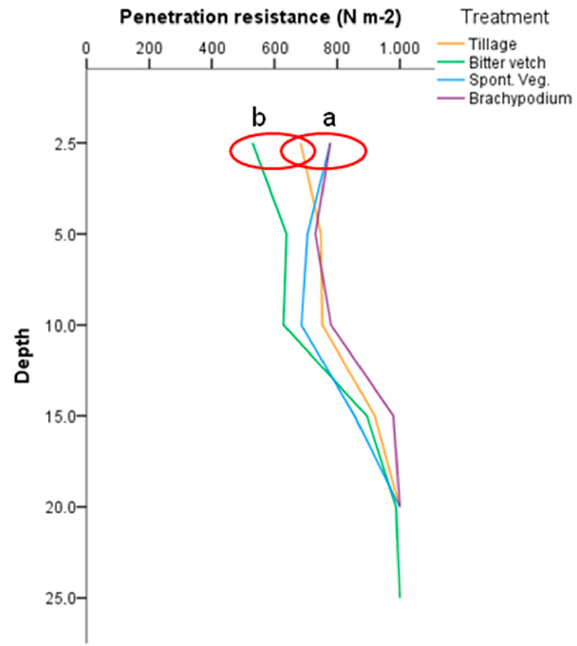
Figure 5. Penetration resistance from 2.5 to 25 cm depth for the different treatments. Statistical differences between treatments at p < 0.05 according to Tukey test (N = 12) were marked with a red ring and different letters.